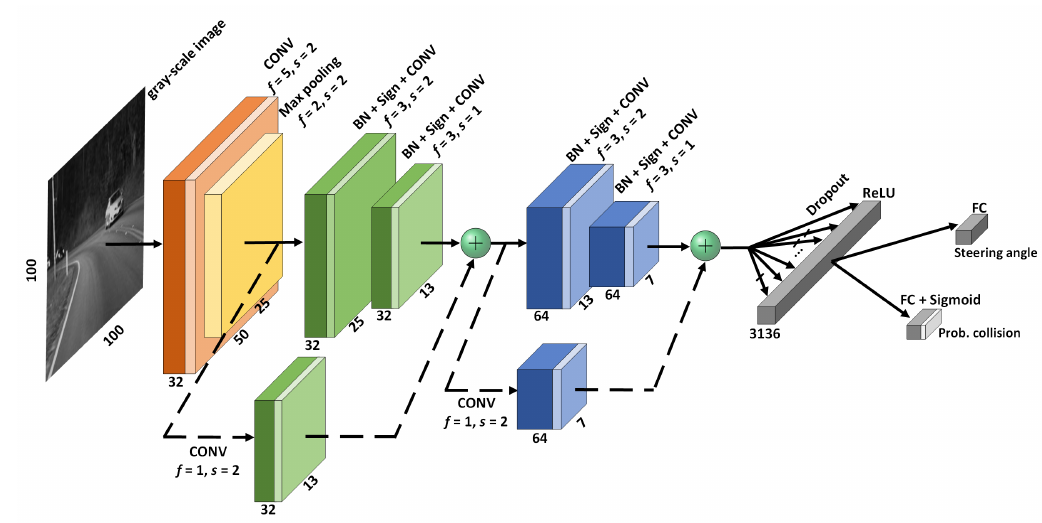
Figure 1. Network topology of EBDN model, in which essential architecture is a 6-layer network with 2 residual blocks and two separate fully-connected layers for judgement of steering angle and prediction of collision probability, respectively. The f as indicated above is the pooling or convolution kernel’s size, and the s is the corresponding